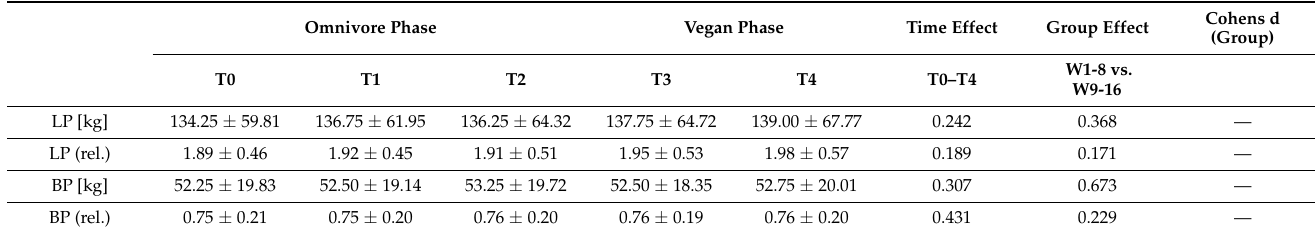
Table 2. Change in strength capacity for the leg press and bench press.